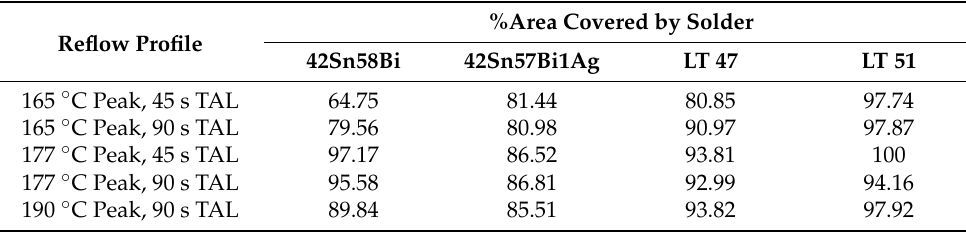
Table 3. Examination of solder coverage of copper pad as a function of reflow